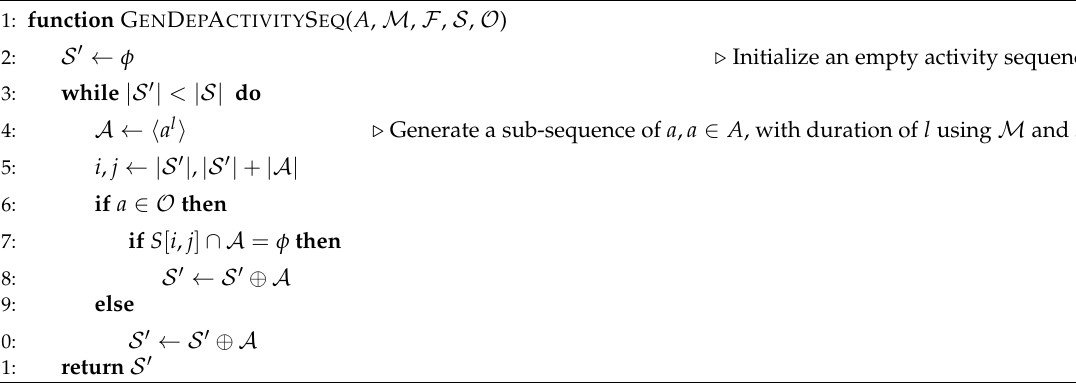
Algorithm 3 Generate a dependent activity sequence with the condition (8).